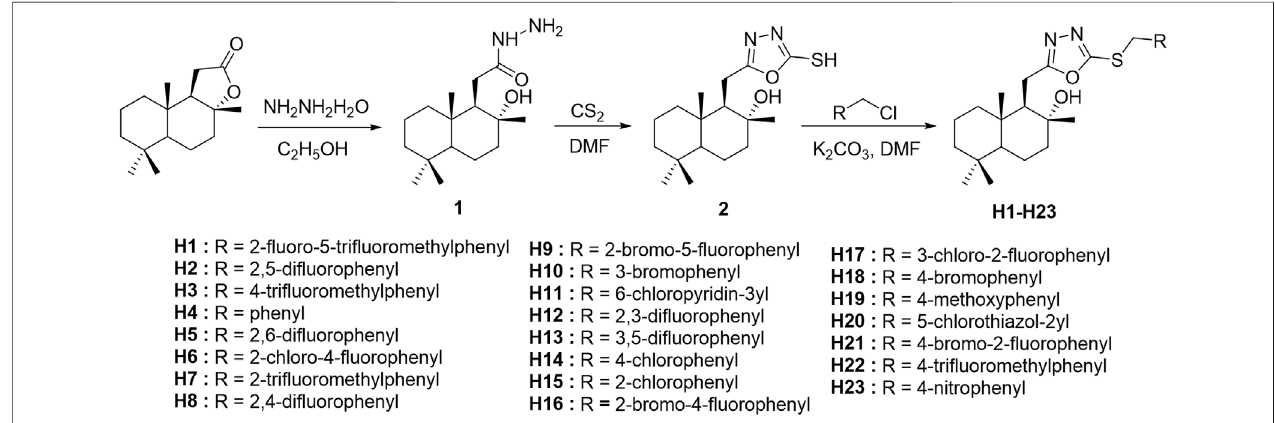
SCHEME 1 | The synthetic route of the target compounds H1-H23 .